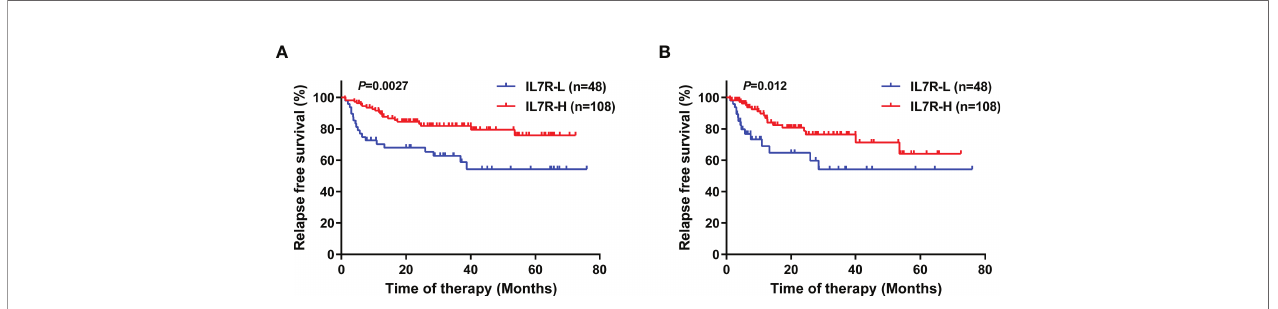
FIGURE 2 | The impact of IL7R transcript level at diagnosis on relapse in t(8;21) AML patients using Kaplan – Meier survival analysis (log-rank test). (A) RFS, with no censoring; (B) RFS, with censoring at the time